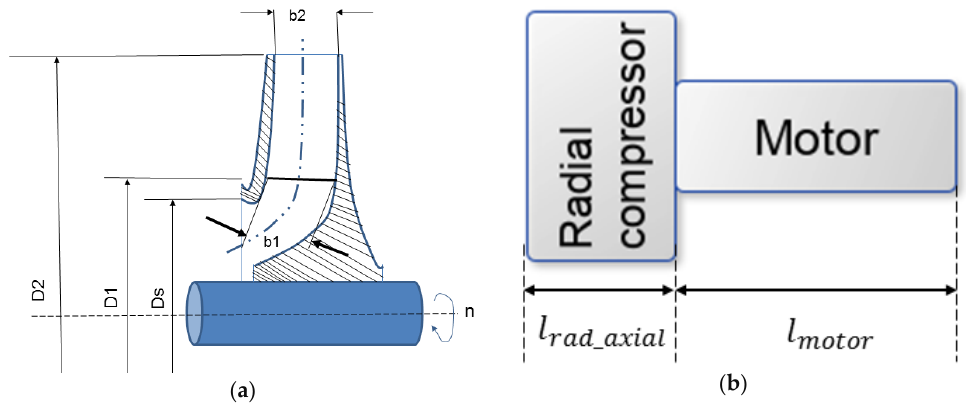
Figure 12. Radial compressor: ( a ) Schematic of impeller blade (meridional view); ( b ) compressor length.